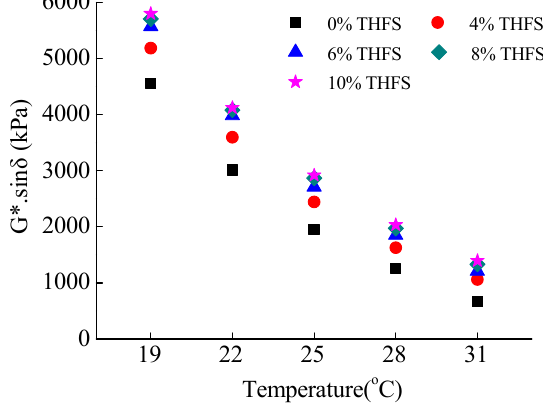
Figure 5. G*·sin δ Values of Asphalt Binders over Temperatures. Figure 5. G* · sin δ Values of Asphalt Binders over